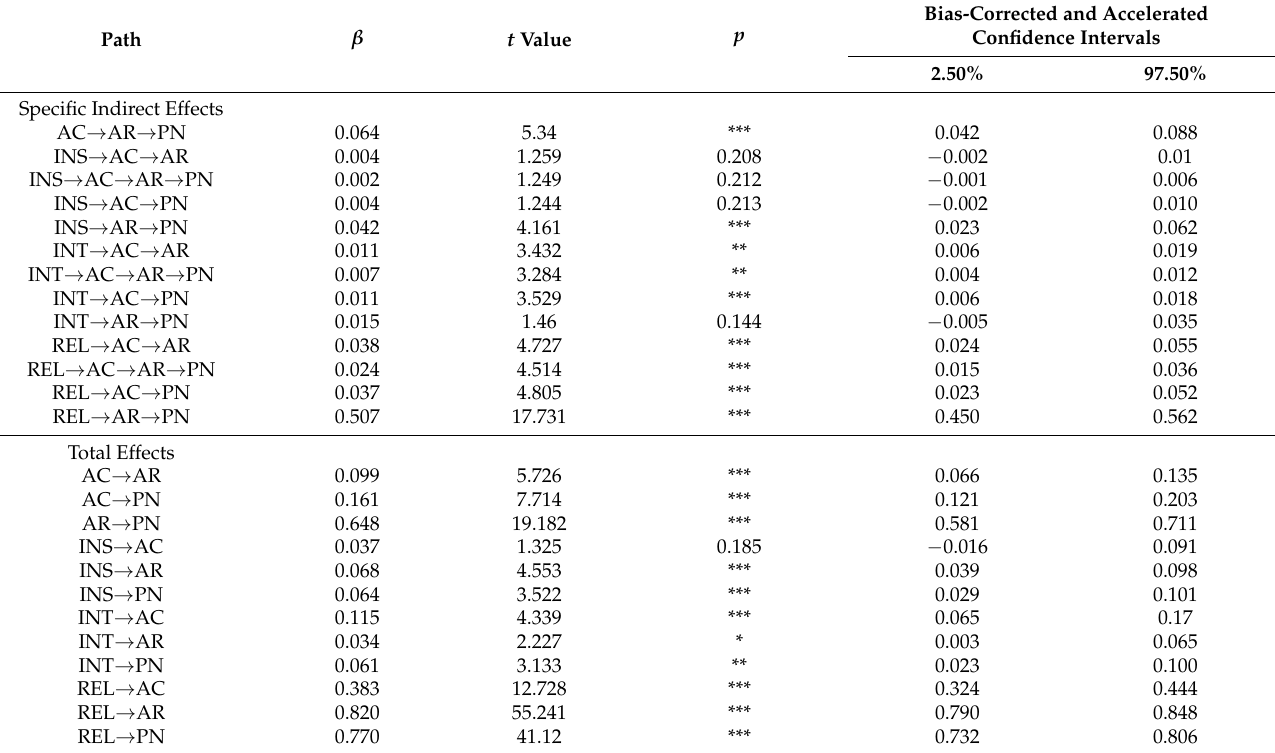
Table 7. Results of path coefficient analysis (indirect and total